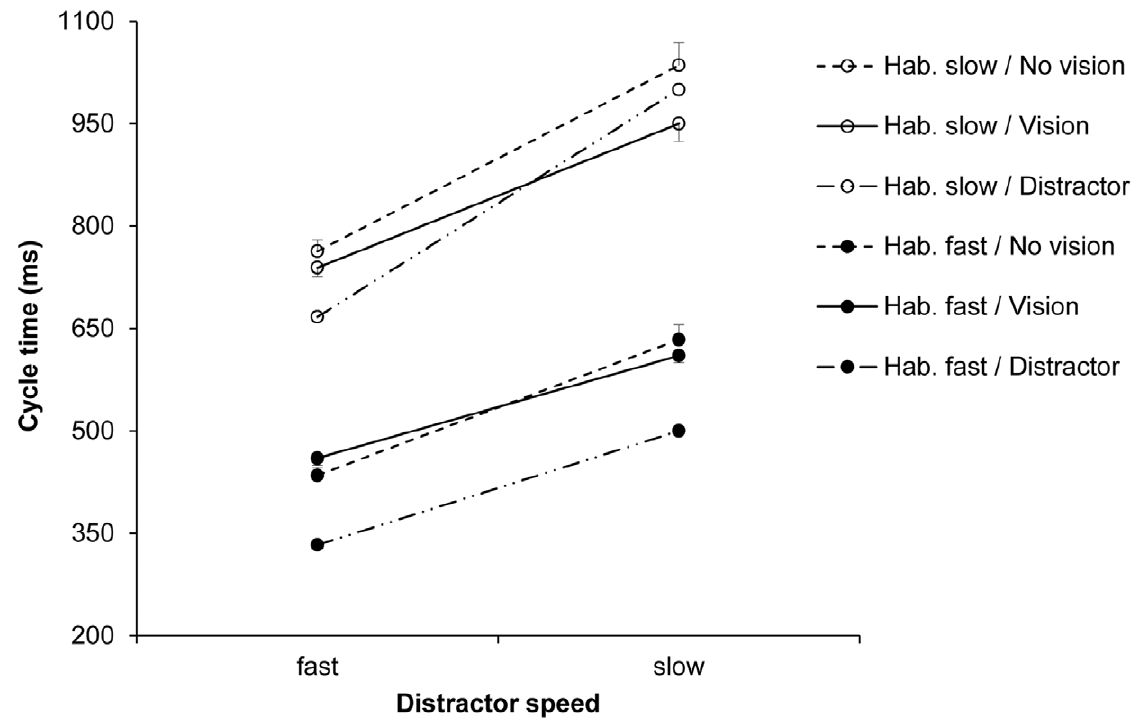
Figure 5. Intentional imitation experiment: Cycle times (ms). Mean cycle times (with standard error of the mean) for the factors habitual speed, distractor speed, and the availability of vision of the hand, displayed relative to the actual distractor speeds.